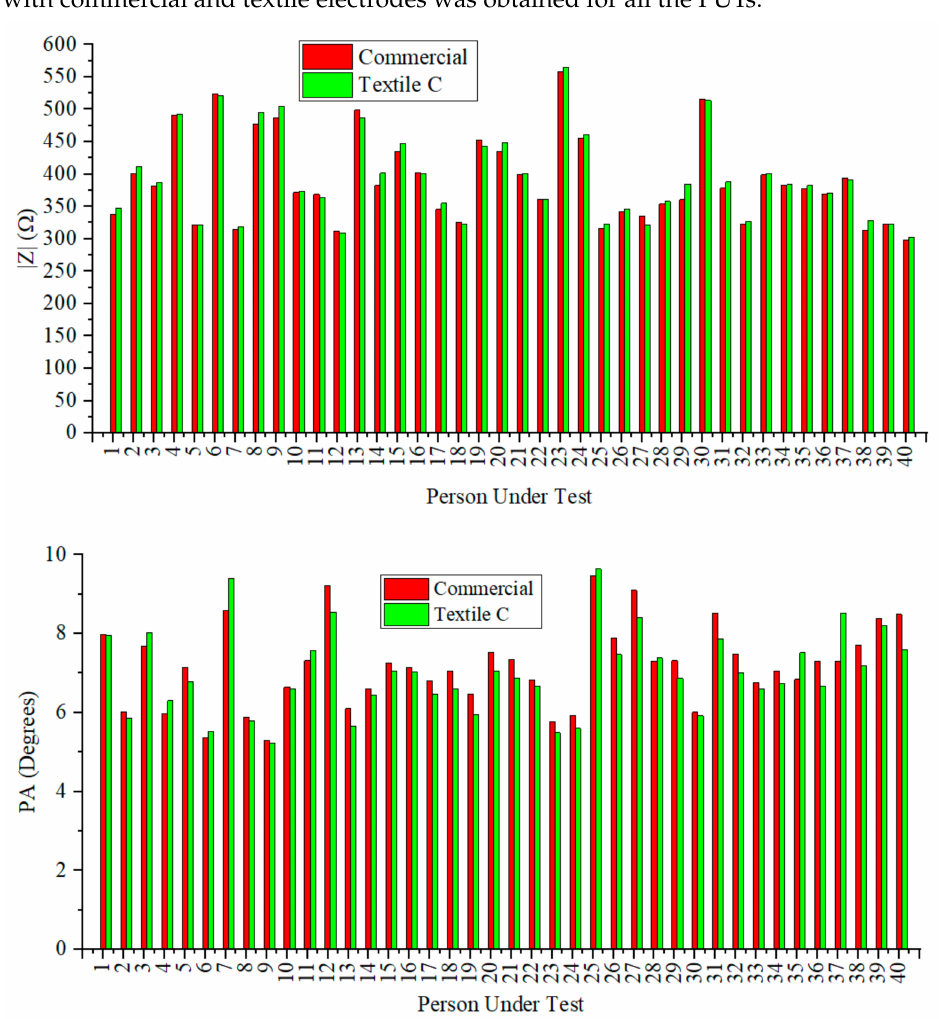
Figure 4. Comparison of the values obtained for | Z | and PA by using the Ag/AgCl commercial electrodes and the Textile C